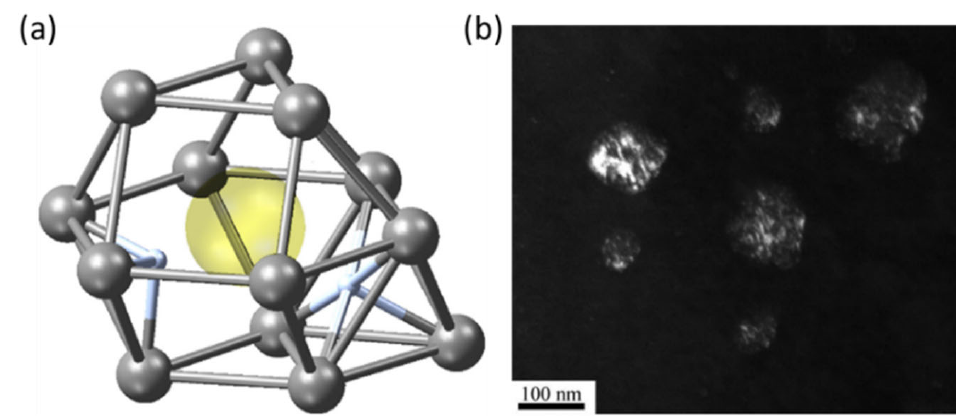
Figure 6. ( a ) Hydrogen atoms (blue) around a vacancy (yellow) of Zr lattice in three-fold (left) and five-fold (right) coordinates [21]; ( b ) fark-field image of circle-like hydride [89]. Reprinted with permission from [21]; Copyright 2020 Elsevier. Reprinted with permission from [89]; Copyright 2019 Elsevier.